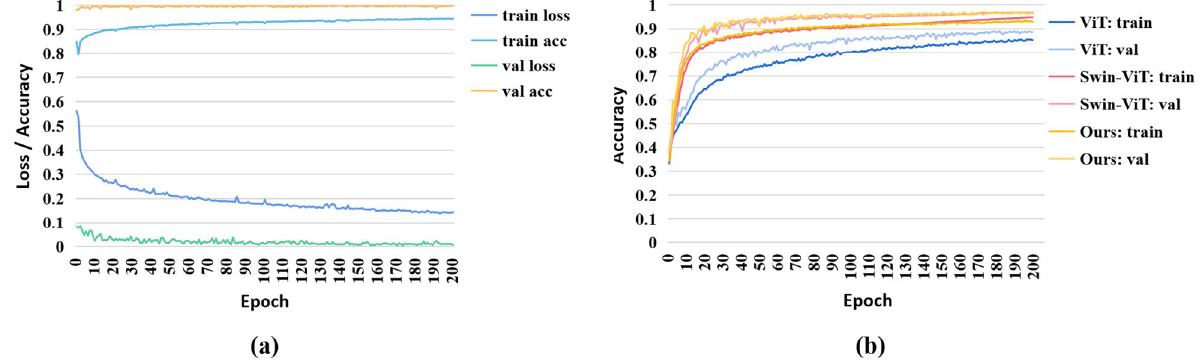
Figure 6. ( a ) The loss and accuracy curves of the proposed model in OCT2017. ( b ) The accuracy curves of different models on